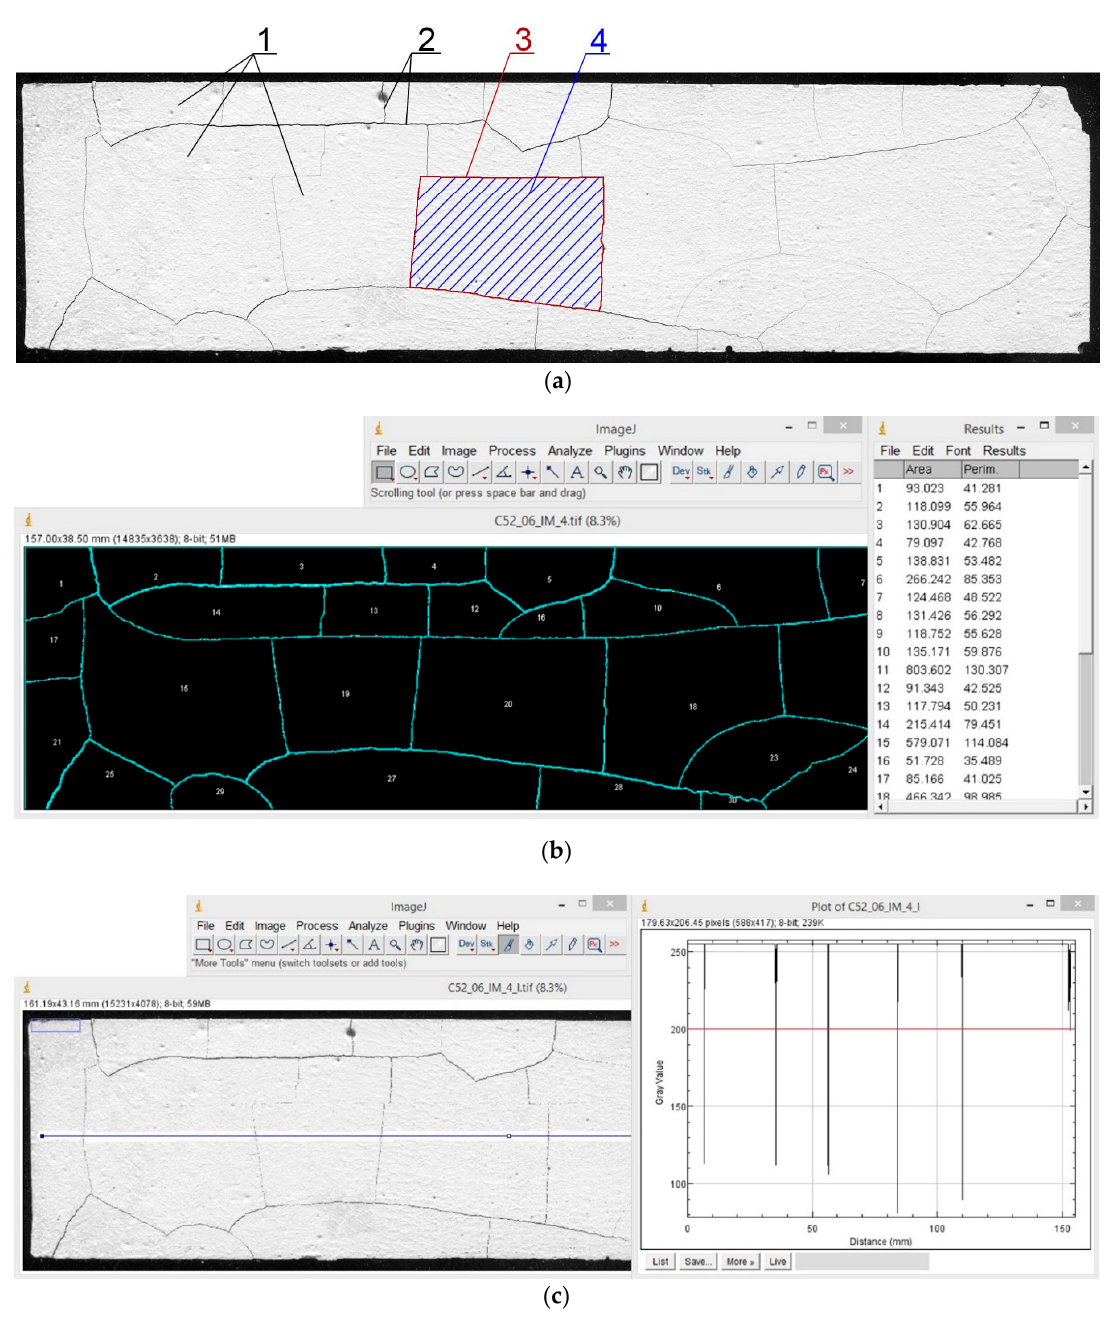
Figure 2. The image of a scanned surface of the cement paste [59]: ( a ) Image obtained after scanning; ( b ) processed and measured ( A and L ) image; ( c ) processed and measured ( I ) image; 1—clusters; 2—cracks forming a cracking pattern; 3—cluster perimeter; 4—cluster